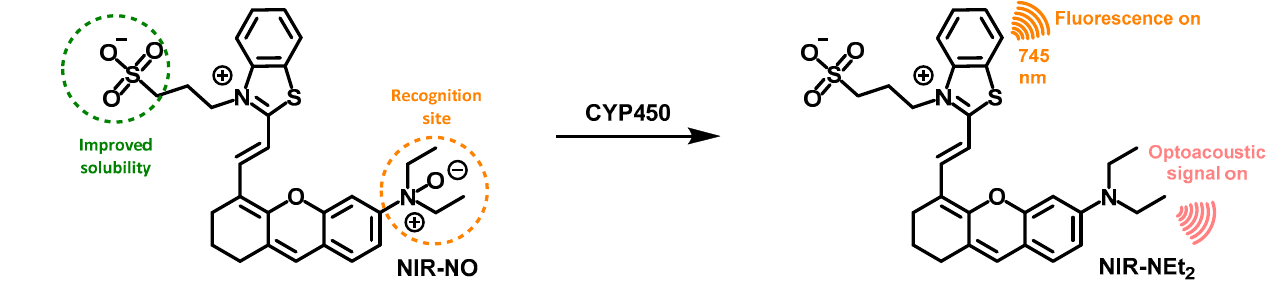
Figure 20. Structure and response mechanism of NIR-NO to CYP450 reductase.